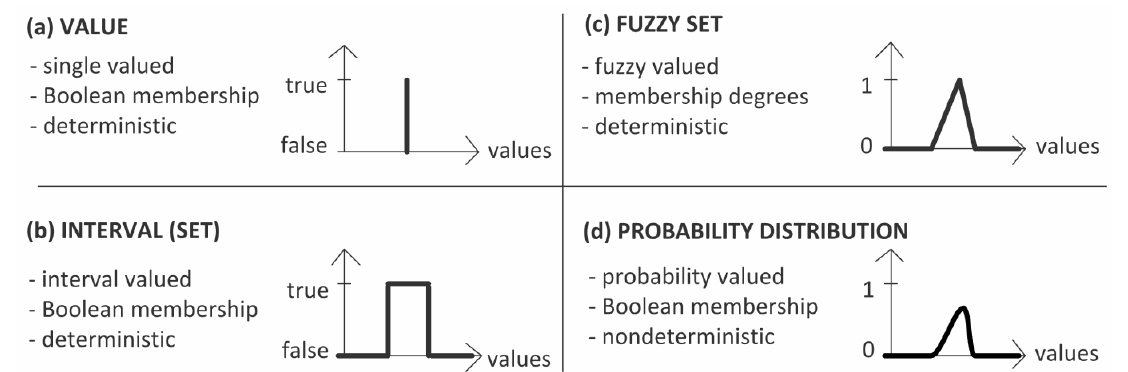
Figure 5. Some different representations of a simulation